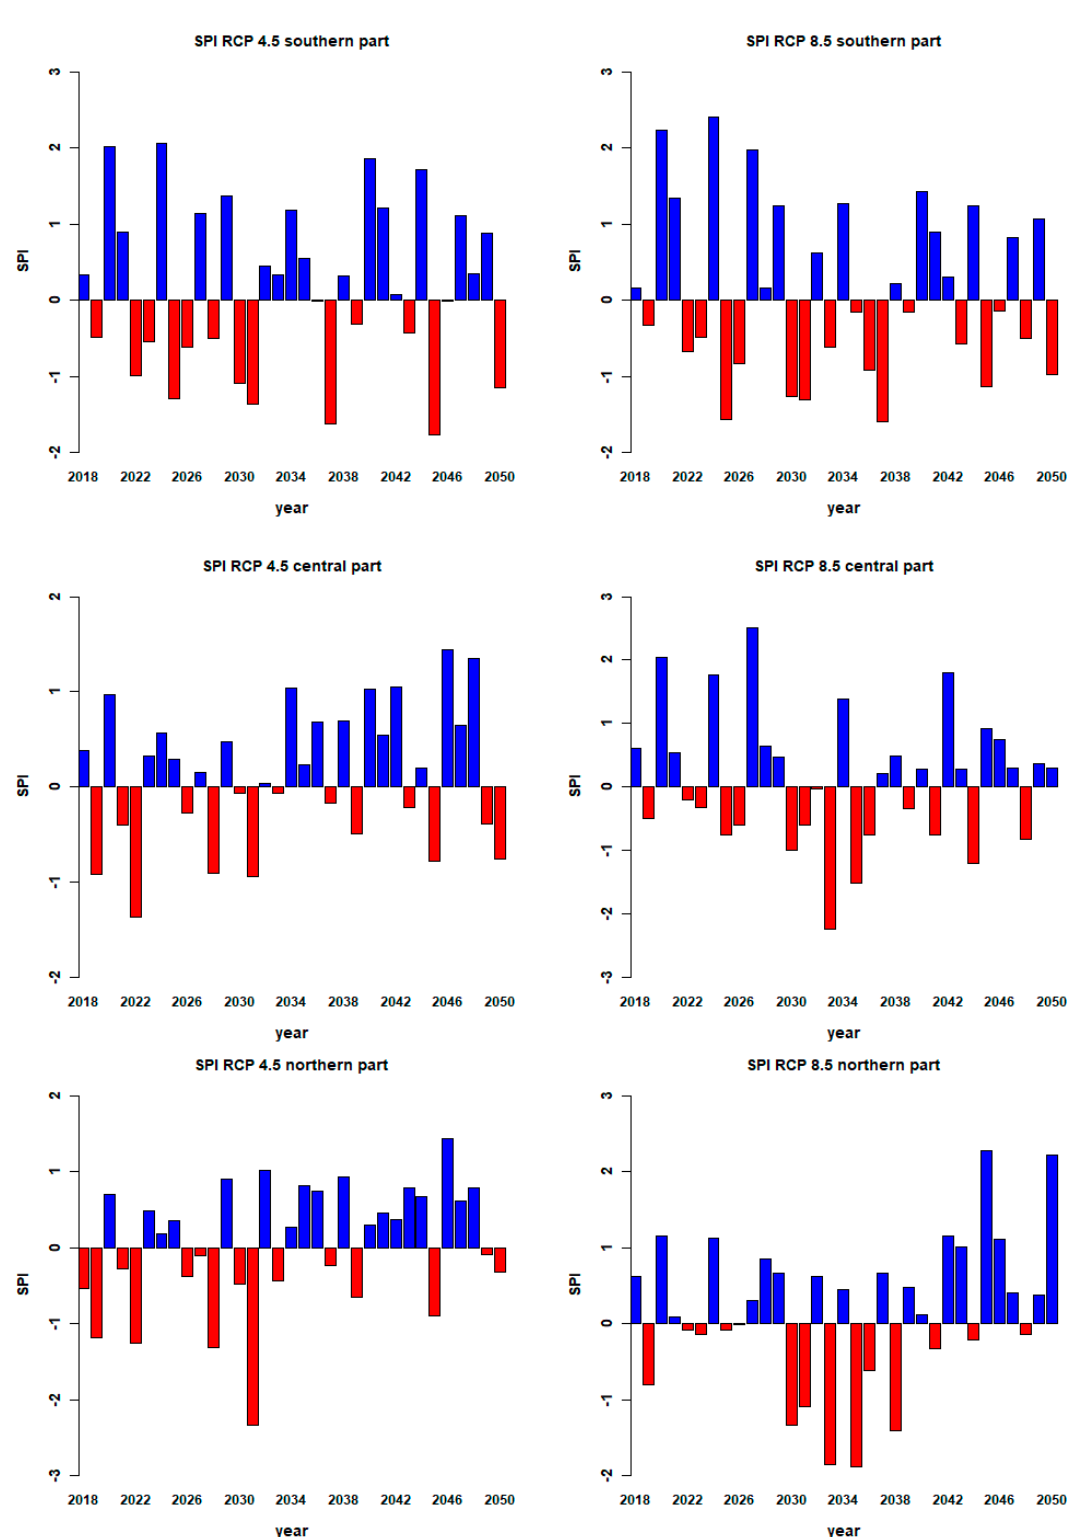
Figure 5. Standardized precipitation index of annual rainfall under RCP4.5 ( left panel ) and RCP8.5 ( right panel ).